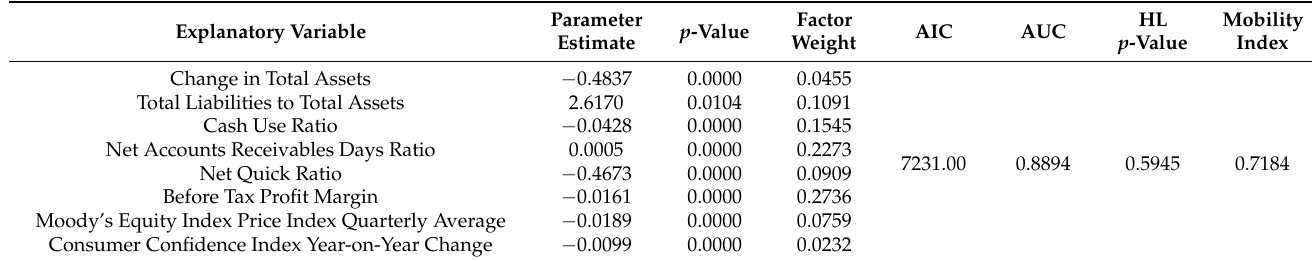
Table 8. Logistic Regression Estimation Results—Moody’s Large Corporate Financial and Macroeconomic Explanatory Variables 1-Year Default Horizon PIT Reduced Form Model 1.